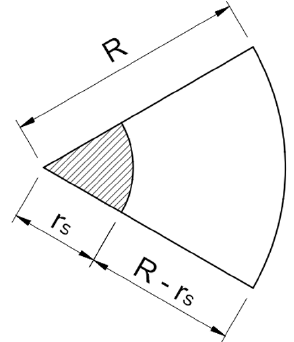
Figure 1. Spherical tributary